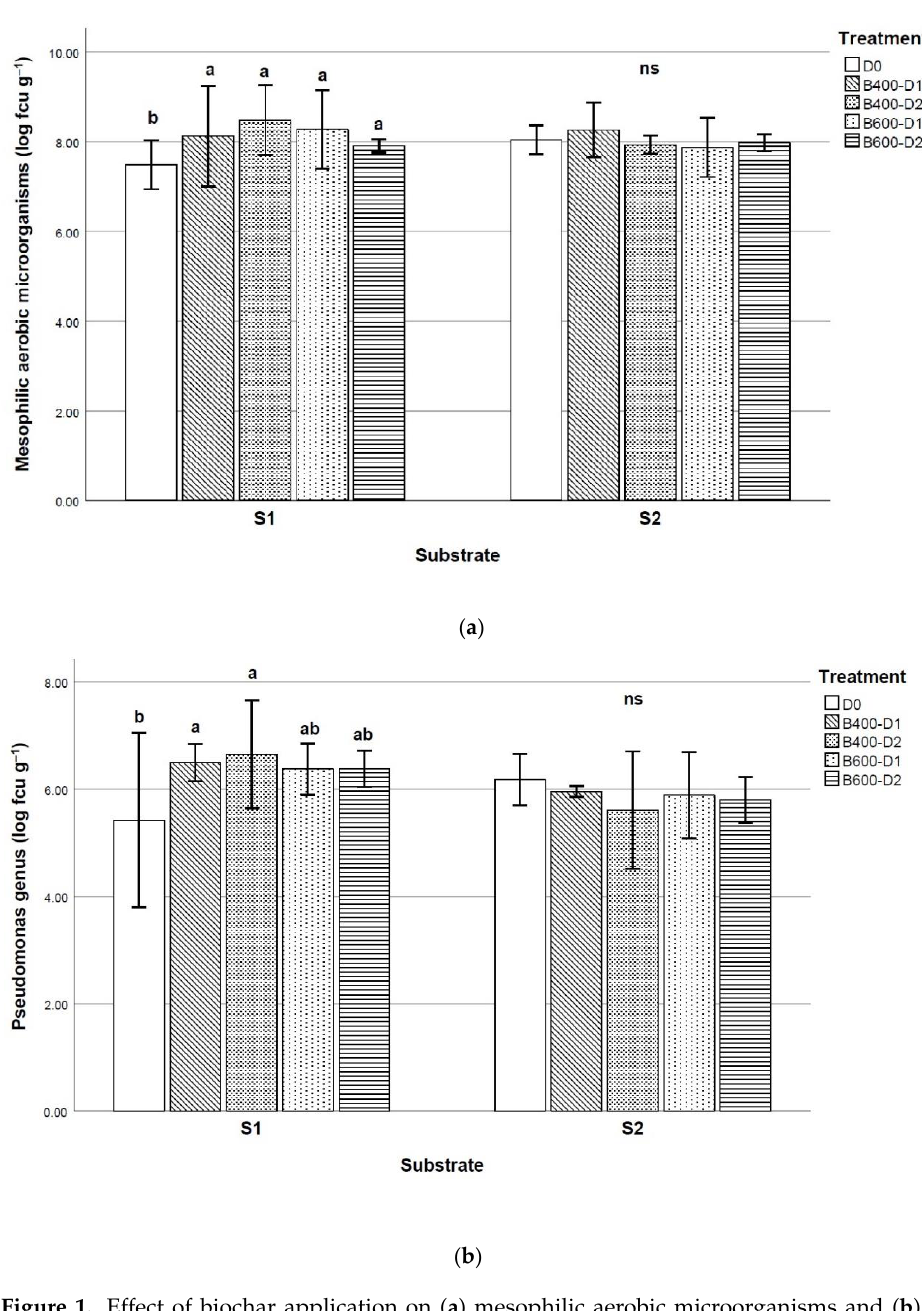
Figure 1. Effect of biochar application on ( a ) mesophilic aerobic microorganisms and ( b ) Pseudomonas genus. (Final py- rolysis temperature of biochar B400—400 °C and B600—600 °C; D0–Control without biochar, D1—1.5 wt. %, D2—3 wt. %; domonas genus. (Final pyrolysis temperature of biochar B400—400 ◦ C and B600—600 ◦ C; D0–Control S1—sandy-loam substrate, S2—clay-loam substrate). Different letters show statistically significant differences at p ≤ 0.05 without biochar, D1—1.5 wt. %, D2—3 wt. %; S1—sandy-loam substrate, S2—clay-loam (Tukey’s test).